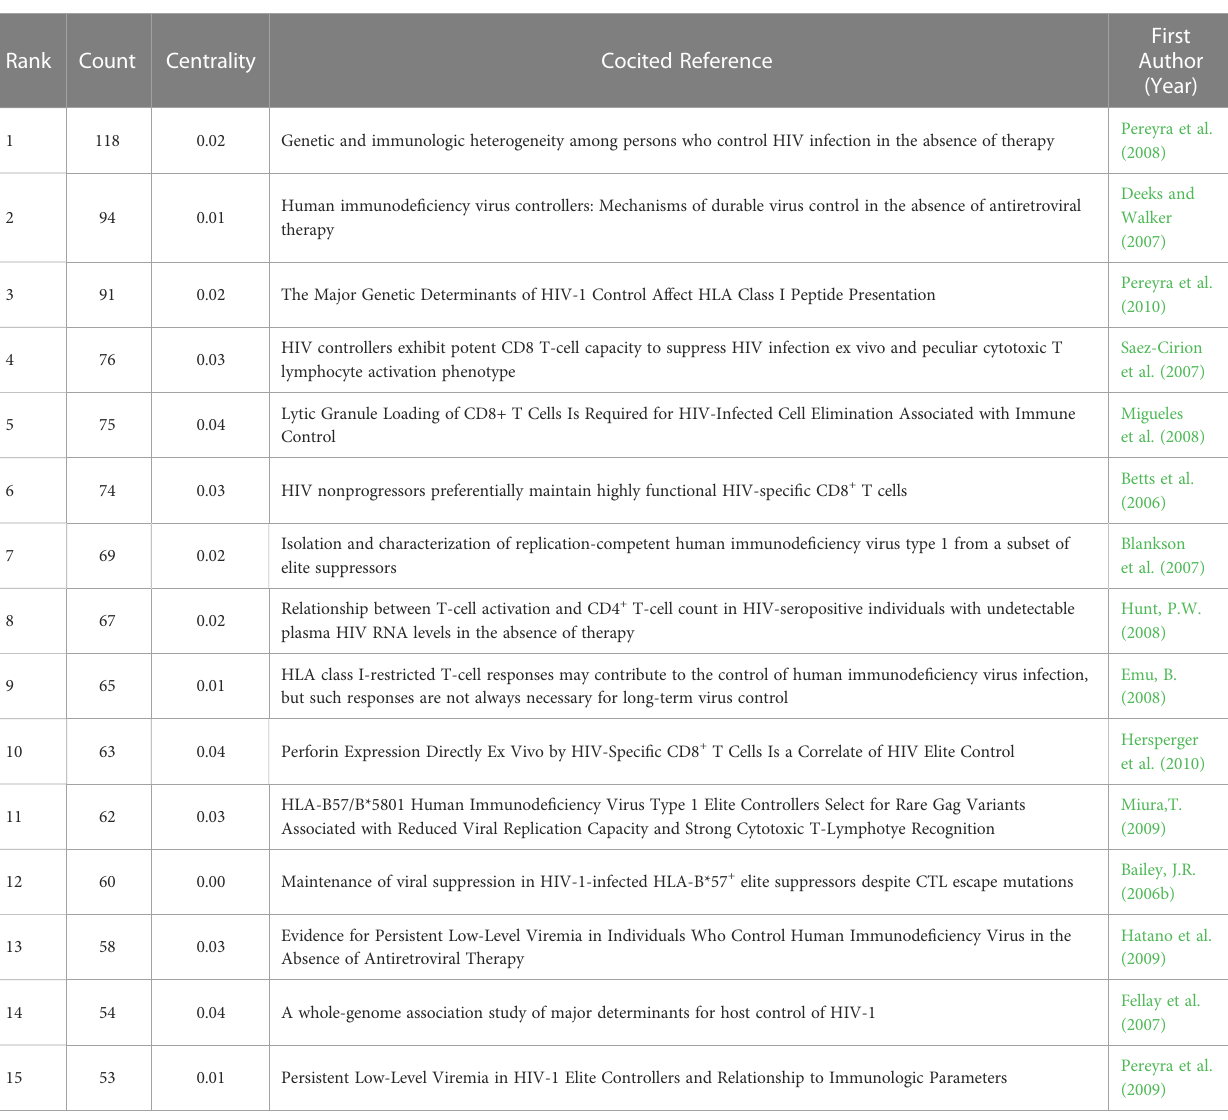
TABLE 5 The top fi fteen references with the most